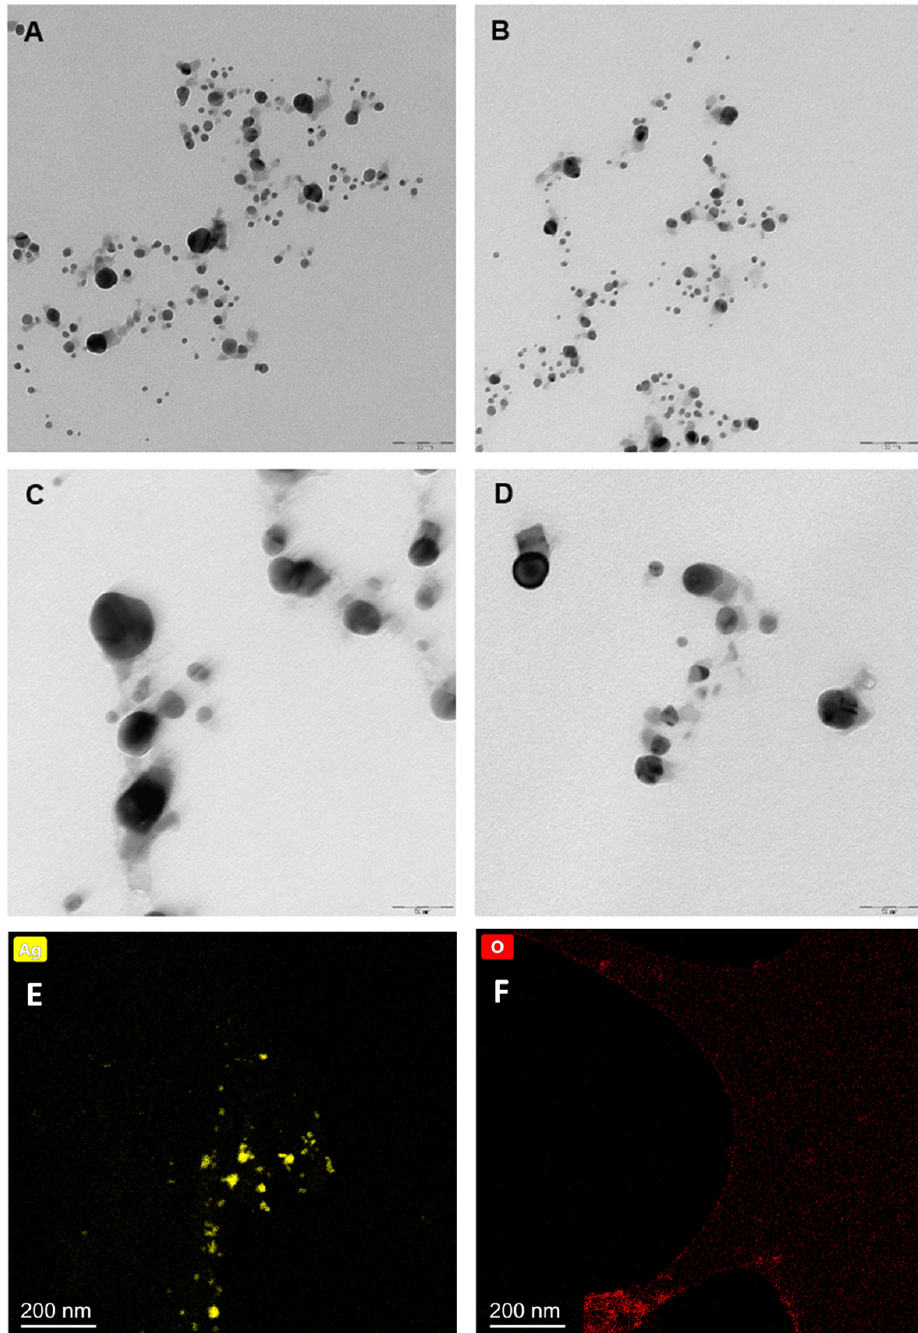
Figure 2. TEM images of matrixless AgNPs. ( A , C ) correspond to the systems after a 6-month period of storage, ( B , D ) correspond to the freshly prepared systems, and ( E , F ) represent EDS elemental mapping for Ag and O for the freshly prepared samples. The scale is 100 nm for the ( A , B ) and 50 nm for the ( C , D ) images.